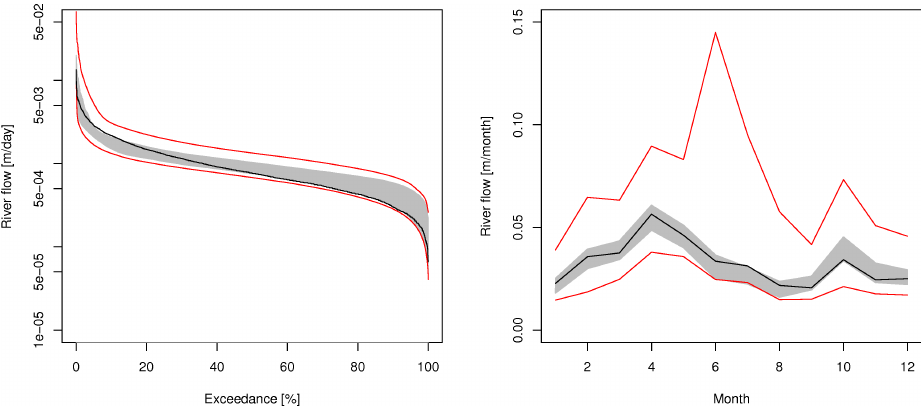
Fig. 6. Uncertainty in the projections of climate change impacts on water resources. Left: flow duration curve; right: mean monthly discharge. The black line is the observed curve, the grey area indicates the 90% uncertainty bounds of the hydrological model during calibration, the red lines indicate the 90% prediction limits for the future scenario (A1B, 2070–2099), including hydrological model and GCM